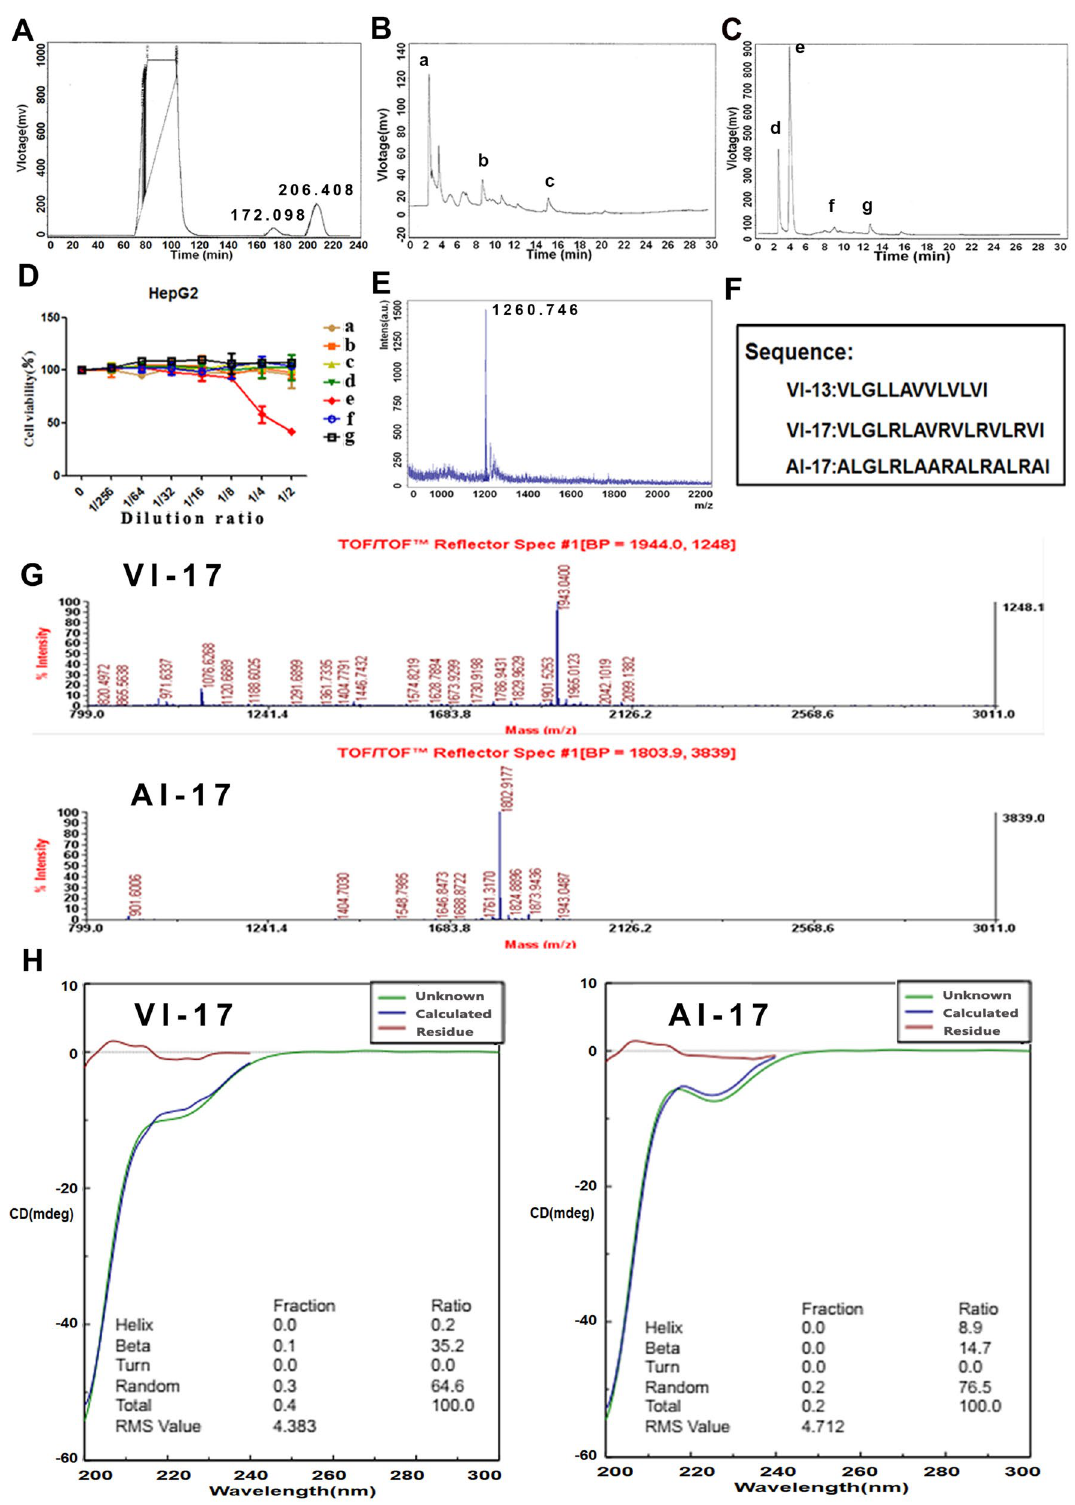
Figure 1. Identification of highly abundant peptide in human umbilical cord serum and the modification. (A) Size Exclusion Chromatograph of human umbilical cord serum. (B,C) Reversed phase liquid chromatography for the samples from A. (D) Bioactivity analysis for samples isolated from B–C. (E) Mass spectrometry analysis for sample e from B–C. (F) The amino acid sequences of peptides in this study. (G) TOF/TOF Reflect spectrum of VI-13, VI-17 and the control peptide AI-17. (H) CD spectra for VI-17 and the control peptide